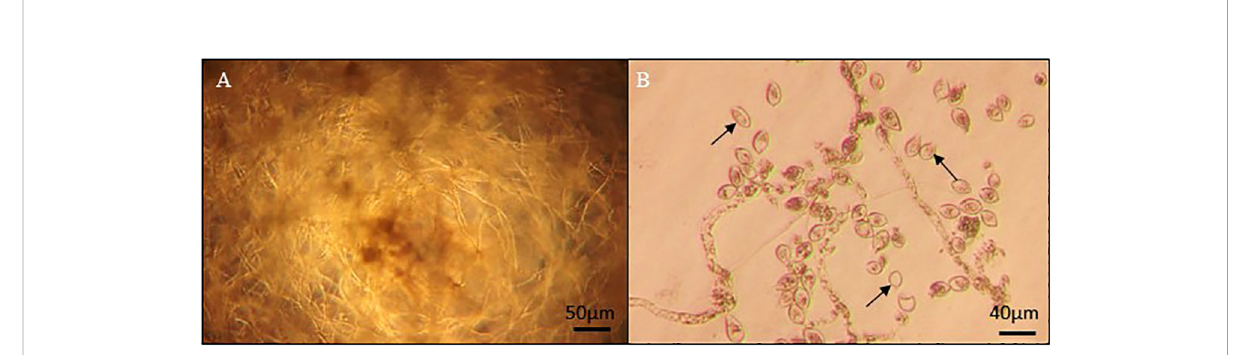
FIGURE 2 Phytophthora MUCL 54981 culture grown in 96-well microplates (A) on PDB medium without culture fi ltrate, showing a dense growing hyphae (B) on PDA with culture fi ltrate of P. aurantiogriseum MUCL 47586, showing the absence of hyphal growth and presence of empty sporangia